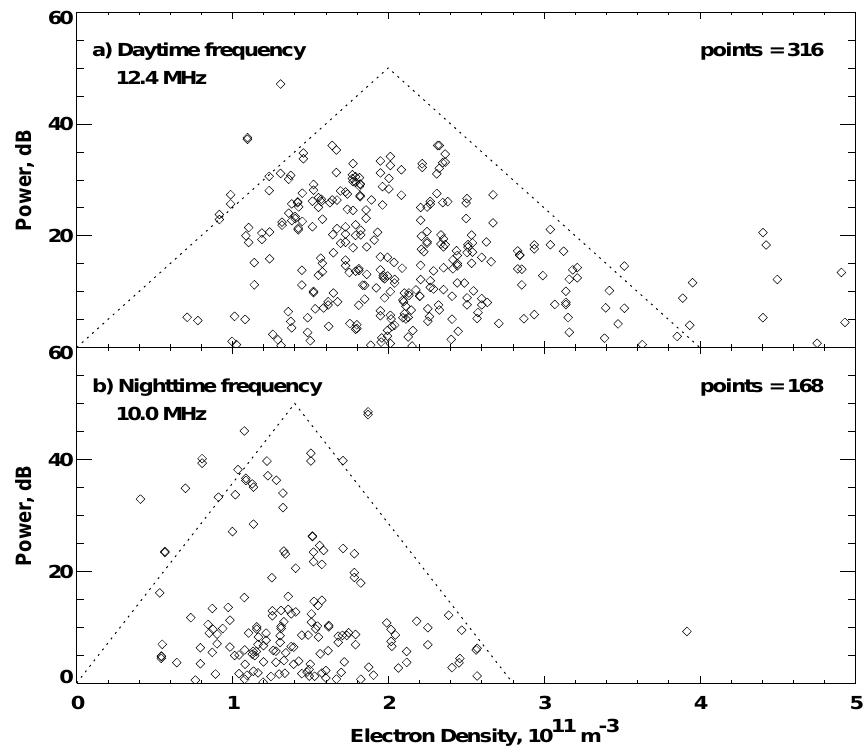
Fig. 6. Echo power versus electron density at the height of 250km (a) for the daytime observations at 12.4MHz (316 points) and (b) for the nighttime observations at 10.0MHz (168 points). Dotted lines roughly encompass the maximum power observed for each electron density at